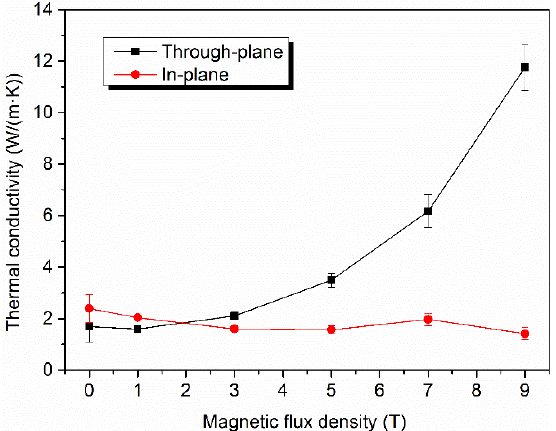
Figure 6. The through-plane and in-plane thermal conductivity of the CF–rubber composites as a function of magnetic flux density.